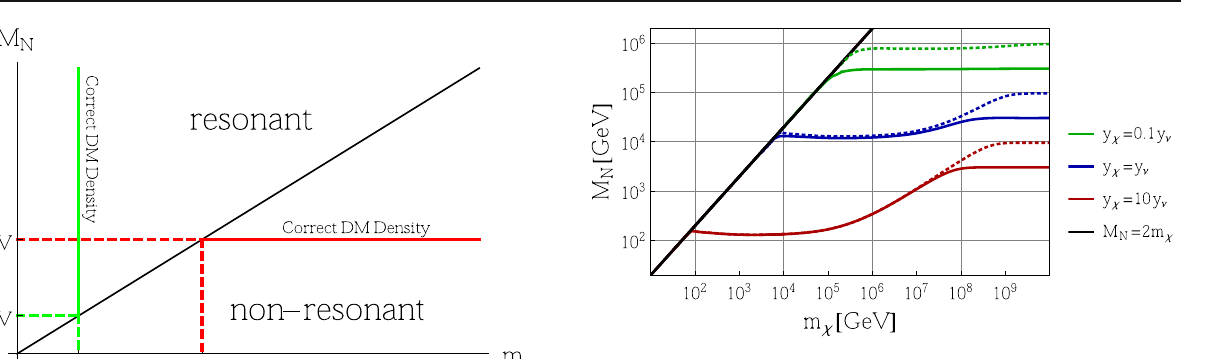
Fig. 4 The numerically obtained DM density Y th is compared to the observed DM density Y exp for different values of the DM mass m χ and the mediator mass M N : the different colored solid lines represent the points where the observed DM density is reproduced for a certain couplingstructure.Aparameterpointaboveaspecificlineoverproduces DM for the corresponding coupling structure while points below do not generate enough DM. Lines of the same color have the same coupling structure. A solid line represents a scenario with of f 1 (θ) = 1, while a dotted represents a scenario with f 1 (θ) = 0 . 1. The black line separates the plane into the non-resonant (lower right) and resonant (upper left) regime. The latter one was not scanned. We assumed normal ordering and one massless